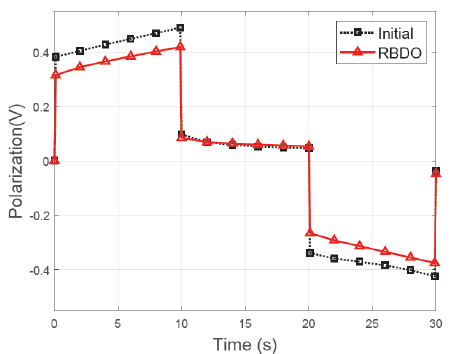
Figure 8. Comparison of total polarization between the initial and optimized designs in the hybrid pulse power characterization (HPPC) test.